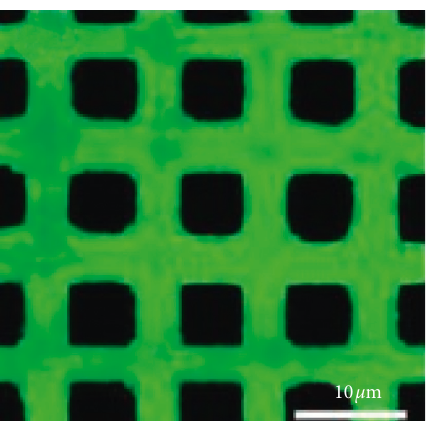
Figure 11: Raman D band mapping for a CVD-grown graphene film after a patterned photochlorination. [39].